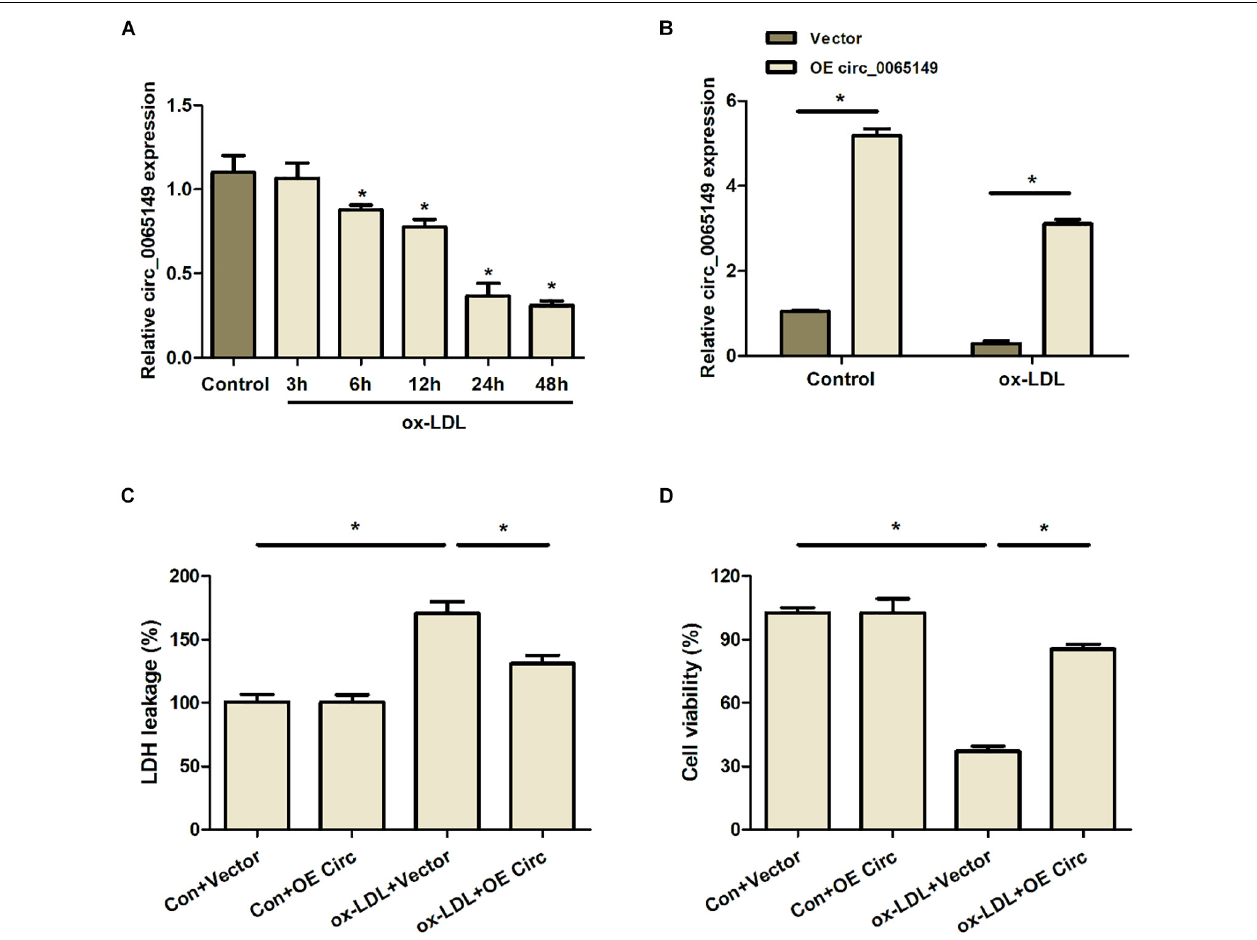
FIGURE 1 | Overexpression of circ_0065149 promoted the viability of HUVECs treated with ox-LDL. (A) Expression of circ_0065149 in HUVECs was measured by qRT-PCR. * P < 0.05 vs. the Control group. (B) Expression of circ_0065149 in HUVECs transfected with Vector or OE circ_0065149. * P < 0.05 vs. the Vector group. (C) LDH leakage was detected using an LDH Cytotoxicity Assay Kit. * P < 0.05, ox-LDL + Vector vs. the Con-Vector group; ox-LDL + OE Circ vs. the ox-LDL + Vector group. (D) Cell viability was measured by a CCK-8 assay. * P < 0.05, ox-LDL + Vector vs. the Con-Vector group; ox-LDL + OE Circ vs. the ox-LDL + Vector group. Data are shown as means ± SD